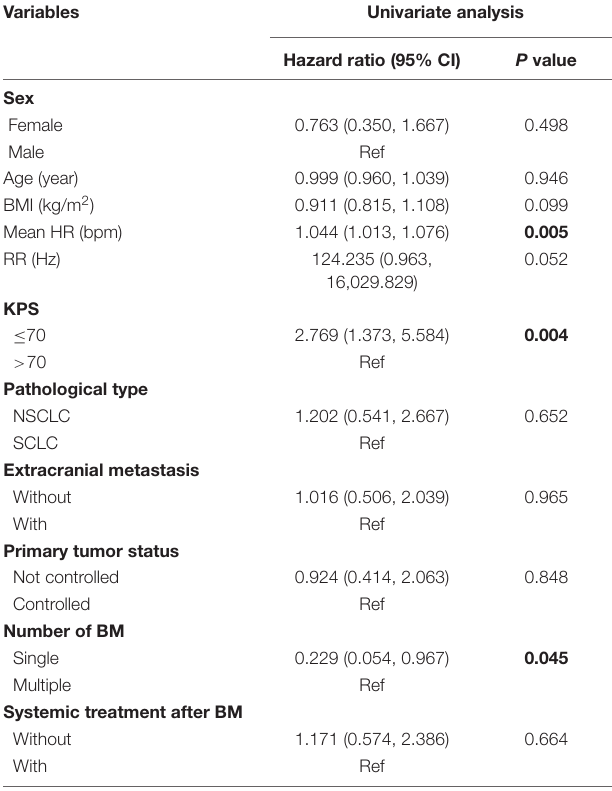
TABLE 2 | Univariate analysis of the baseline patient characteristics associated with survival.